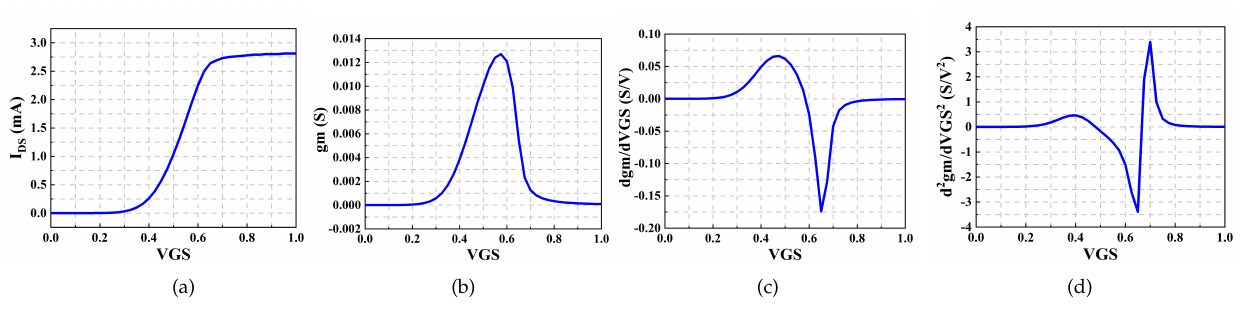
Figure 8. I DS and derivatives versus V GSAUX of auxiliary transistor M AUX . ( a ) I DS ; ( b ) g ma ; ( c ) g 2 a ; ( d ) g 3 a .